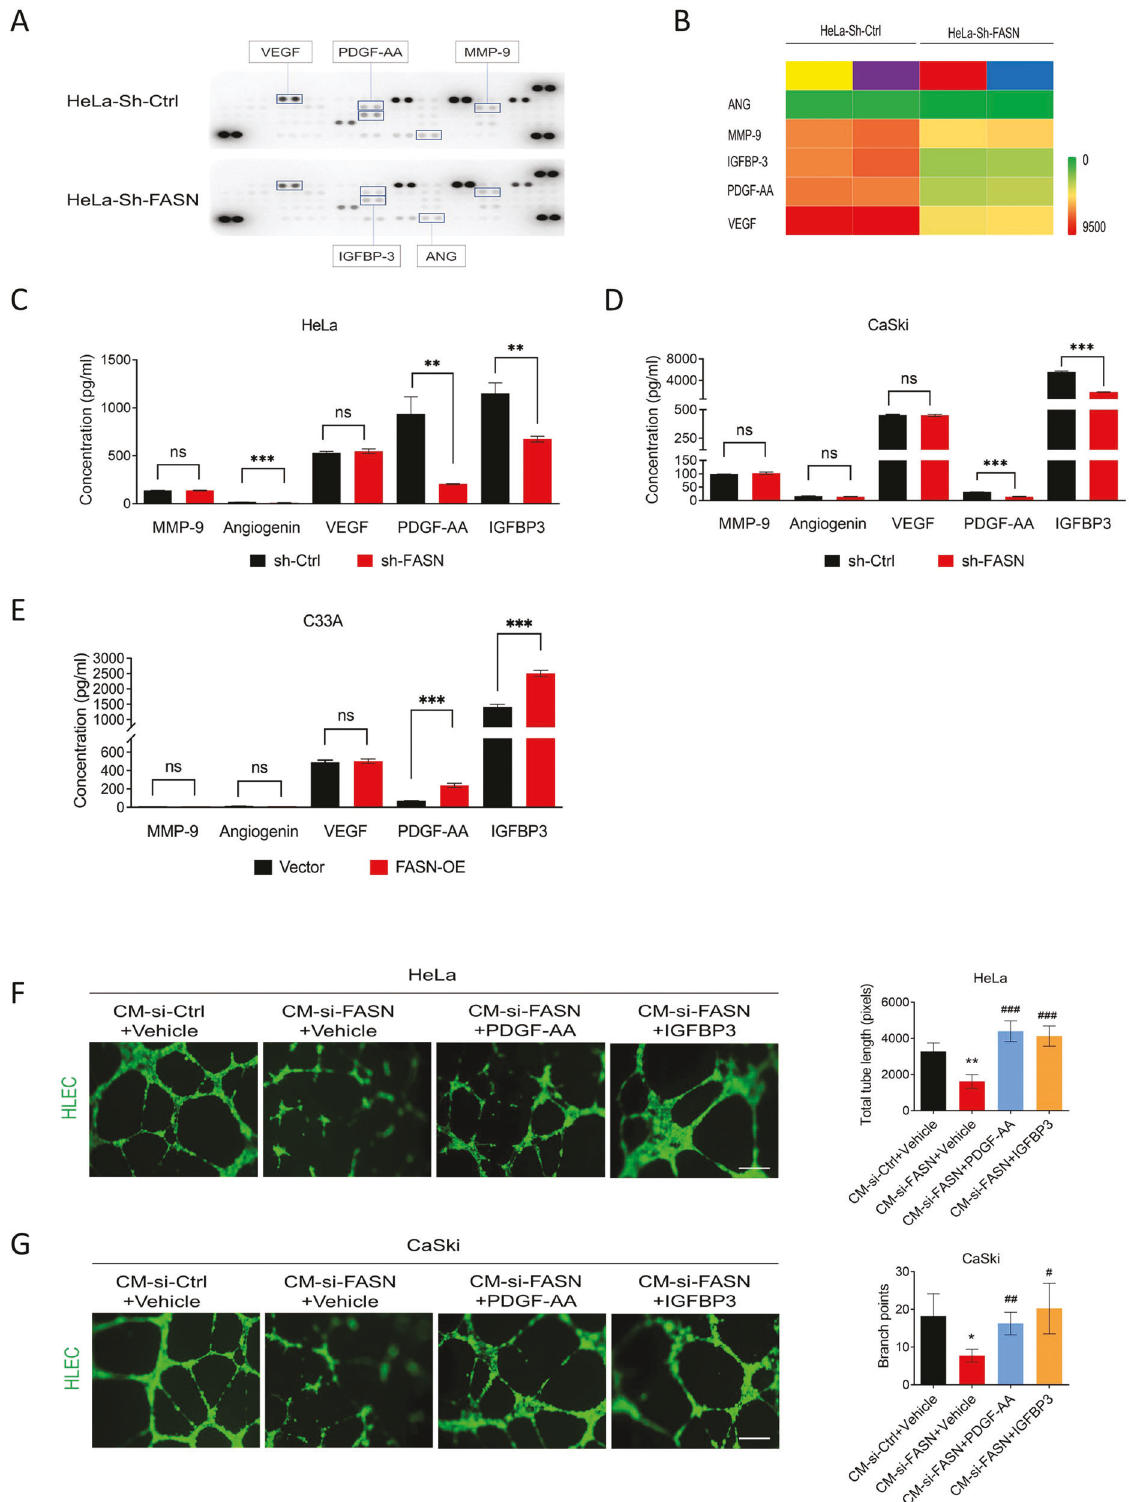
Fig. 6 FASN induces lymphangiogenesis by secreting PDGF-AA and IGFBP-3. A Human angiogenesis array kit results showed fi ve differentiated angiogenesis-related factors in the HeLa-sh-Ctrl and HeLa-sh-FASN groups. Each group contained three replicates of the culture supernatant mixture. B Heatmap of these fi ve factors in A based on pixel analysis. C , D ELISA validation of MMP-9, Angiogenin, VEGF, PDGF-AA, and IGFBP-3 in the culture supernatant of the FASN-shRNA-treated HeLa and CaSki cells. E ELISA validation of MMP-9, Angiogenin, VEGF, PDGF- AA, and IGFBP-3 in the culture supernatant of the C33A-FASN-OE and C33A-vector groups. F , G Rescue experiments showed that the addition of PDGF-AA and IGFBP-3 could rescue the impaired effect of FASN knockdown on lymphangiogenesis. Tube length in tube formation assays was quanti fi ed. * P < 0.05; ** P < 0.01; *** P < 0.001; # P < 0.05; ## P < 0.01; ### P < 0.001, CM-si-FASN-PDGF-AA/IGFBP-3 vs. CM-si-FASN-vehicle.